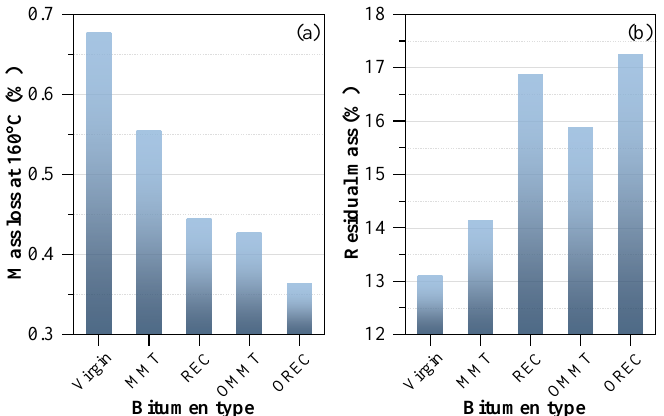
Figure 7. The TG result for bitumen samples: ( a ) Virgin bitumen; ( b ) MMT-modified bitumen; ( c ) REC-modified bitumen; ( d ) OMMT-modified bitumen; ( e ) OREC-modified bitumen.